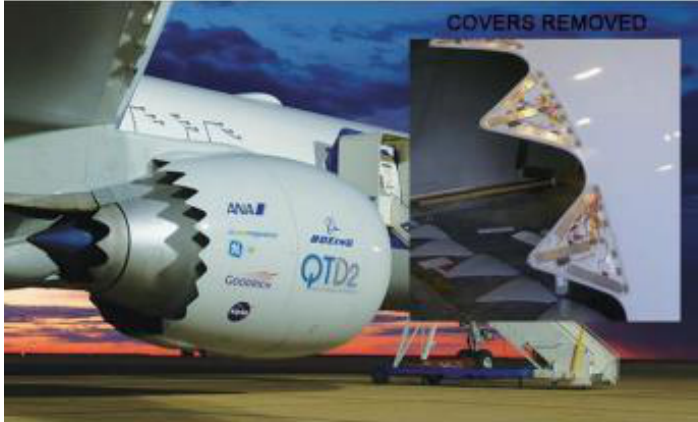
Figure 16. Application of Ni-Ti alloy formed by AM in aerospace field [45].